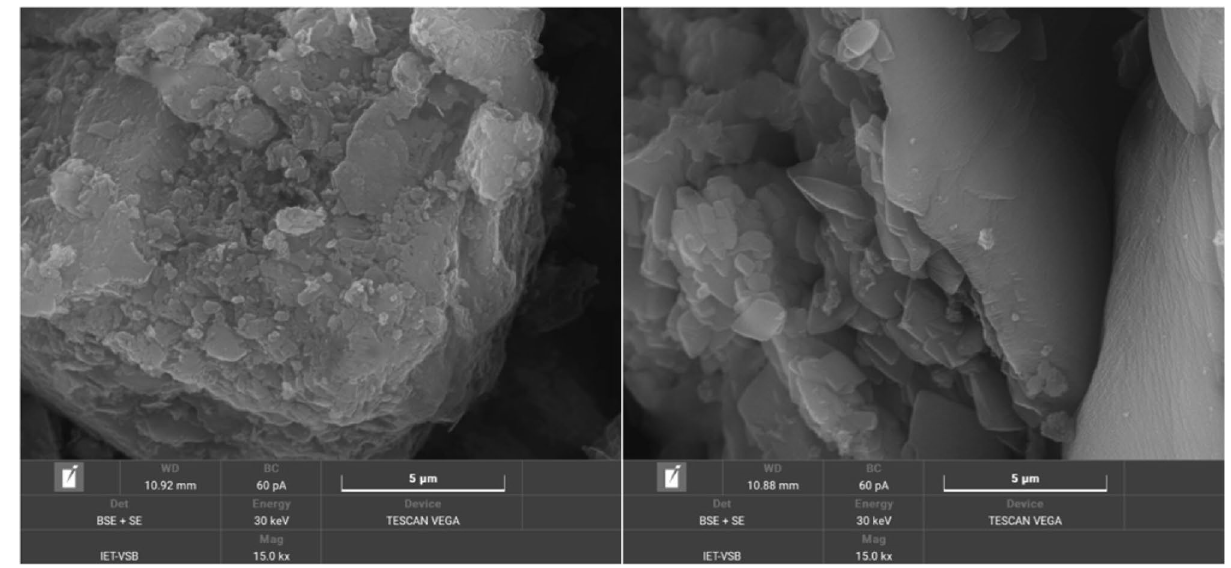
Figure 9. SME (BSE + SE) micrographs of CN (left) and CN-Ar0 (right).